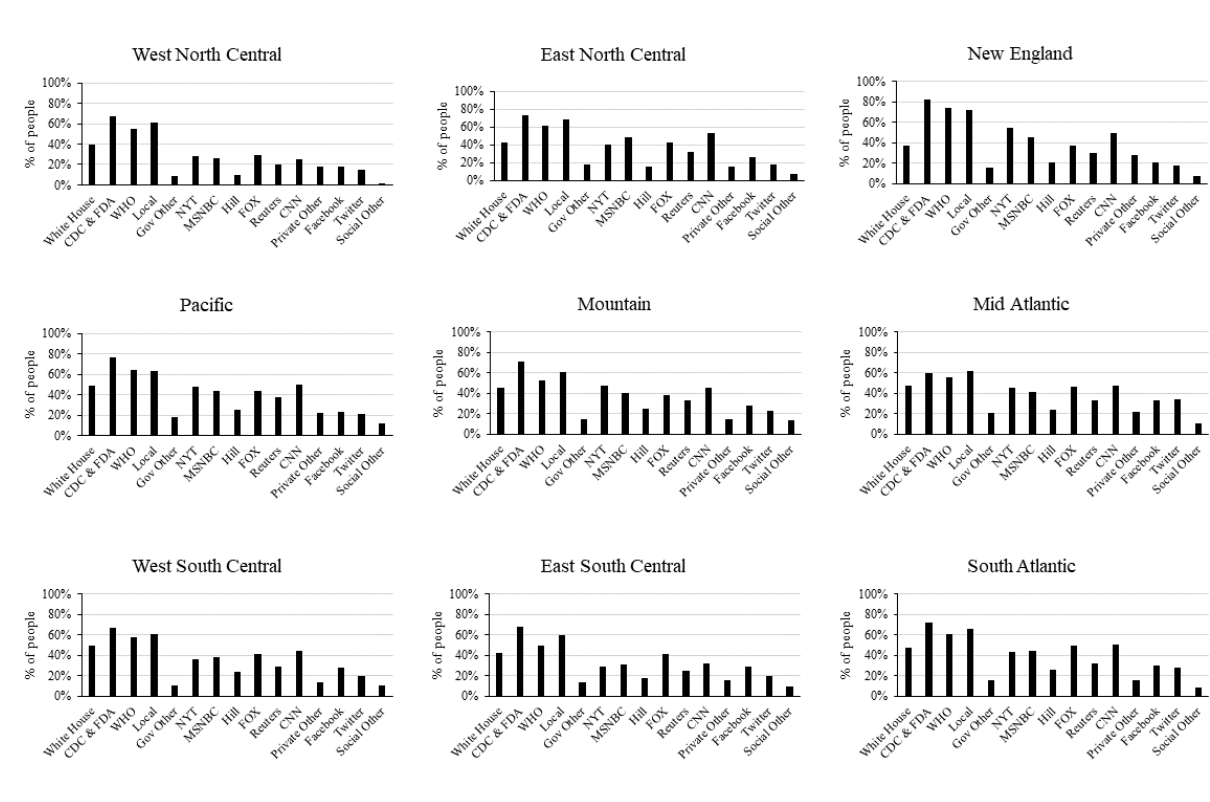
Figure 2. Percentages of participants who trusted in information sources (out of all people in a given region) presented by region and by information source. CDC: US Centers for Disease Control and Prevention; FDA: US Food and Drug Administration; Gov: government; NYT: New York Times; WHO: World Health